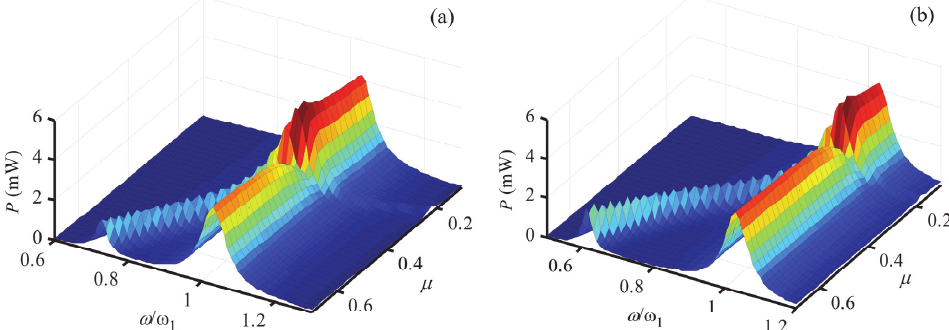
Figure 5. Output power versus excitation frequency for different μ : ( a ) α = 0.34; ( b ) α = 0.23.